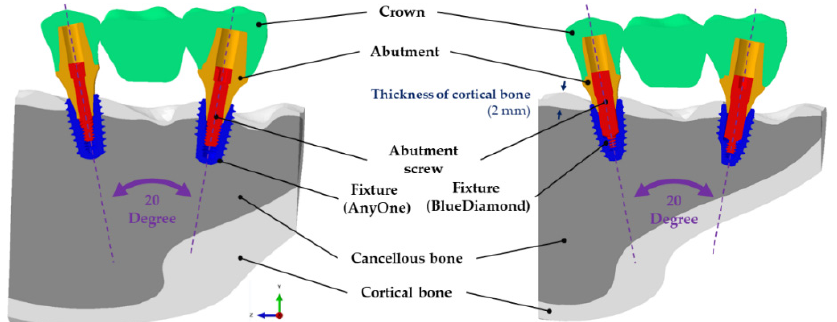
Figure 4. Construction of the finite element surgical model, AnyOne group and BlueDiamond group.